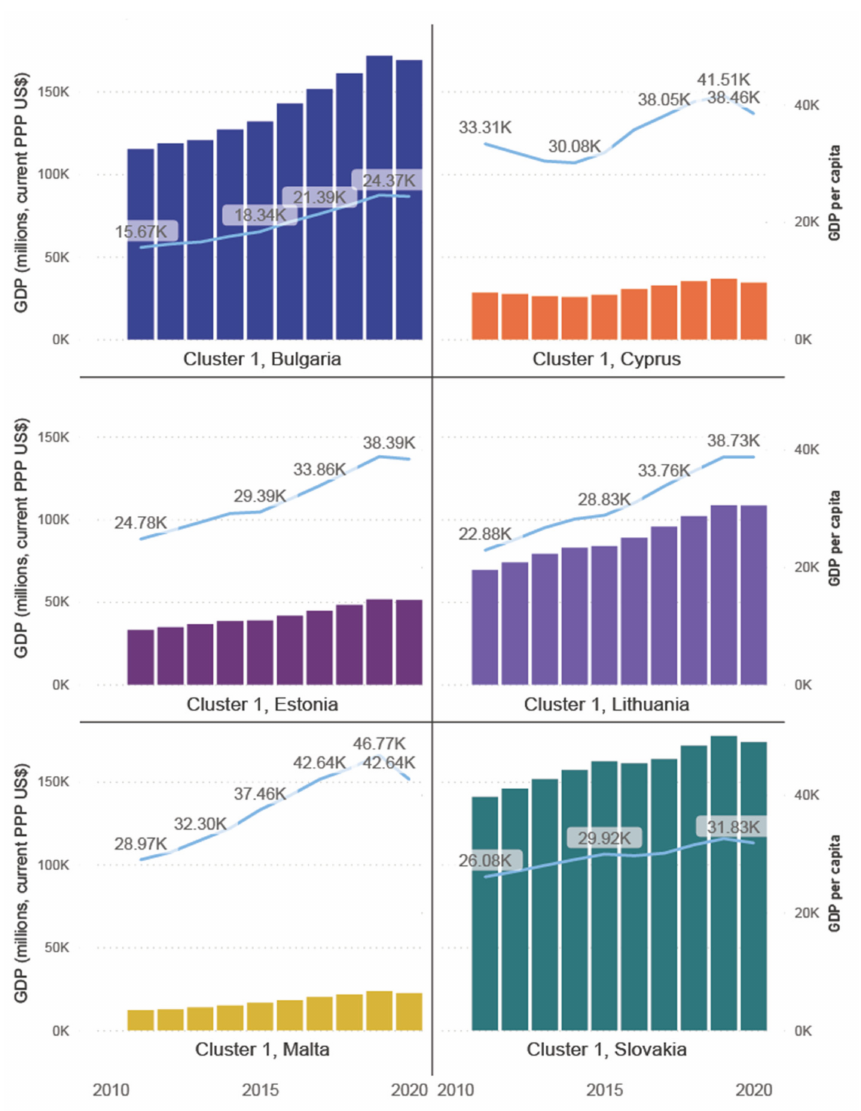
Figure 14. GDP and GDP per capita for the cluster of less robotized countries. Source: Author’s contribu- tion based on data retrieved from International Comparison Program, World Bank, World Development Indicators database, World Bank | Eurostat-OECD PPP Programme. Available at: https://data.worldbank. org/indicator/NY.GDP.PCAP.PP.CD and https://data.worldbank.org/indicator/NY.GDP.MKTP.PP.CD, accessed on 10 March